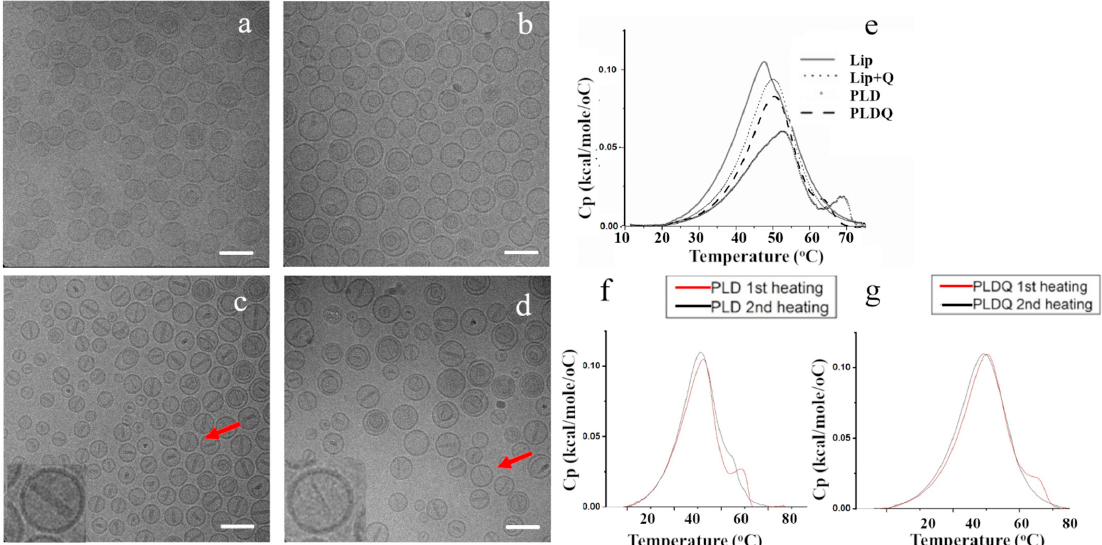
Figure 1. Structural characterization of PLD and PLDQ. ( a ). Cryo-TEM images of empty liposomes (Lip), liposomes remotely loaded with quinine only, ( b ). (Lip + Q); ( c ). liposomal doxorubicin(PLD), ( d ). liposomal doxorubicin, and quinine (PLDQ). The insert is sixfold digital magnification. Scale bar 100 nm. ( e ). DSC thermograms for various liposomal preparations. ( f ). DSC thermograms after two heating cycles of PLD. ( g ). DSC thermograms after two heating cycles of PLDQ.